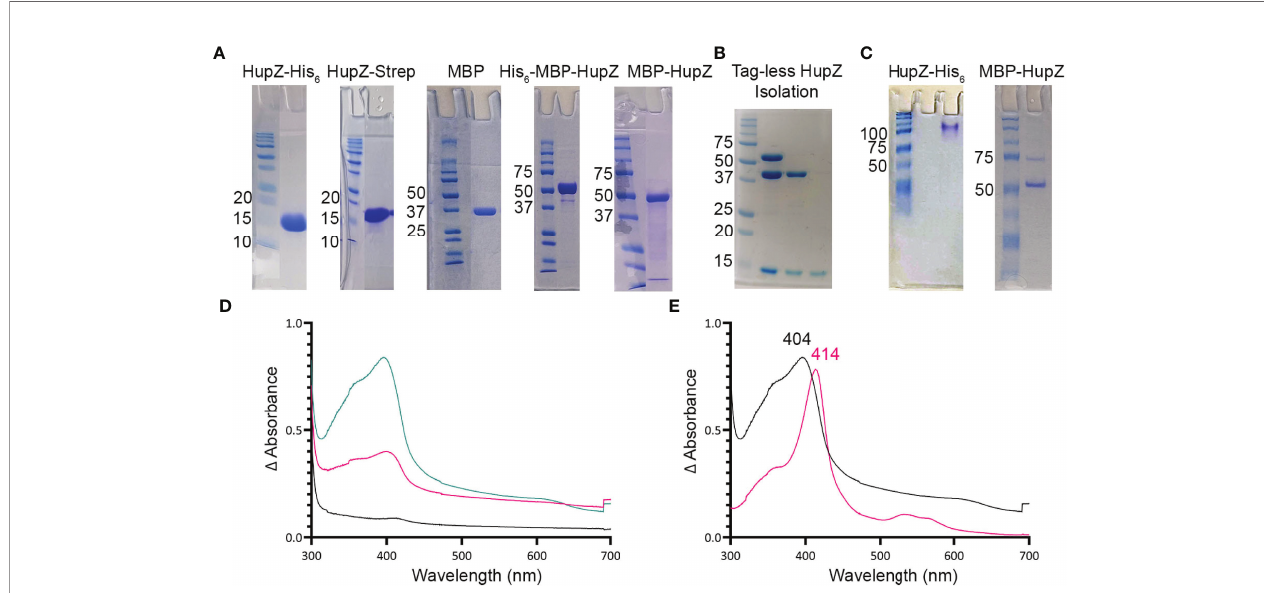
FIGURE 1 | HupZ-Strep binds heme b but without iron coordination. (A) SDS-PAGE showing 10 mM of recombinant proteins next to molecular markers. HupZ- His 6 (18.5 kD) and HupZ-Strep (18.7 kD) were run on 13% acrylamide gel. MBP (40.2 kD) and MBP-HupZ (56.5 kD) were run on 10% acrylamide gels. (B) SDS- PAGE (12.5%) showing the cleavage and puri fi cation of tag-less HupZ (15 kD). Lane 2 shows partial cleavage, lane 3 shows complete cleavage, and lane 4 is